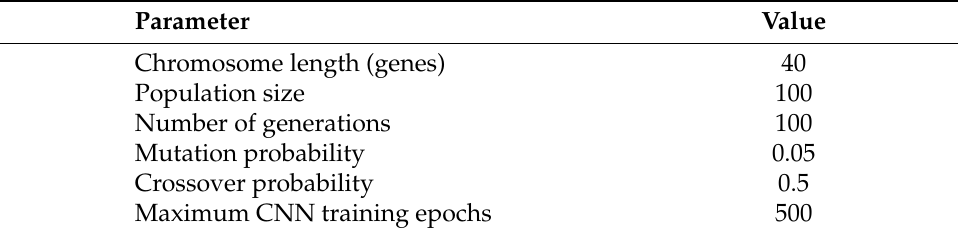
framework stores the set of solutions that survived after each generation in the database, along with the respective values of the fitness functions. Table 2. NSGA-II